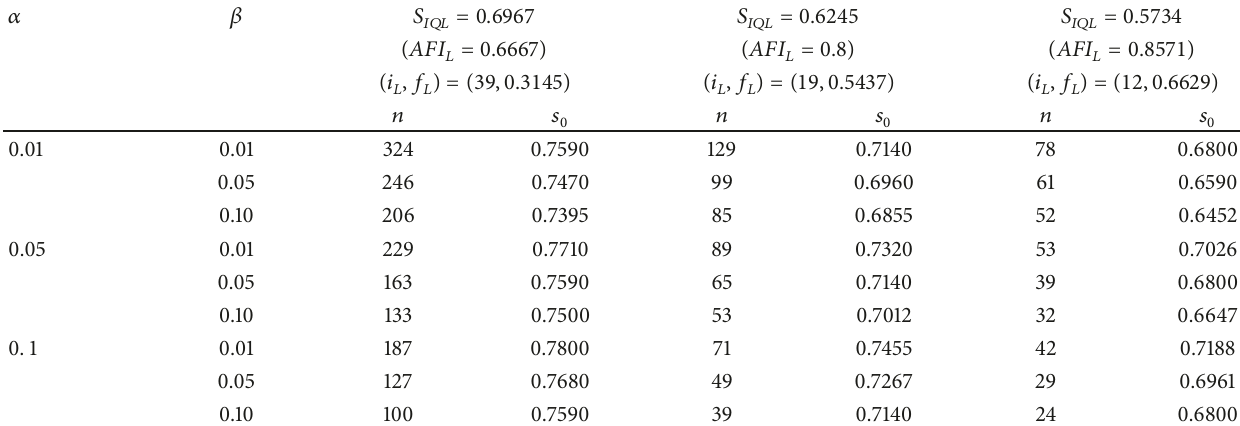
Table 5: The values of (𝑛,𝑠 0 ) at 𝑆 AOQL = 1.2485 ( AOQL = 0.00018) and three levels of 𝑆 𝐼𝑄𝐿 (𝐴𝐹𝐼 𝐿 ) for 𝛼 = 0.01, 0.05, and 0.1 and 𝛽 = 0.01, 0.05, and 0.1